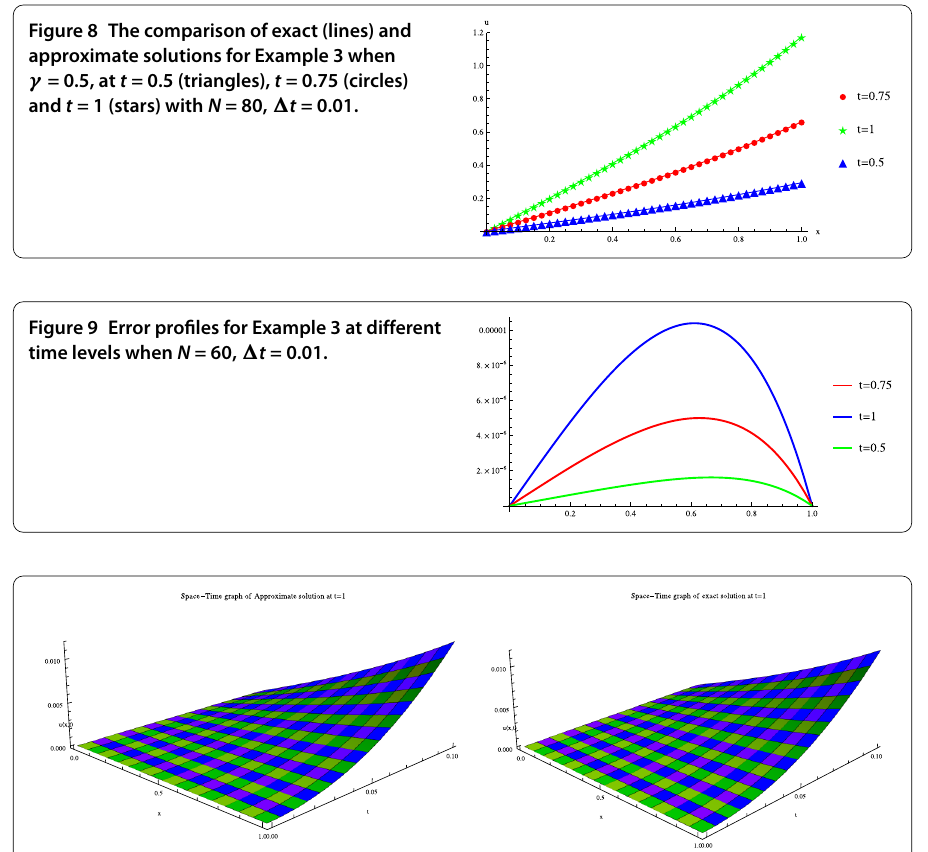
Figure 9 Error profiles for Example 3 at different time levels when N = 60, (cid:2) t = 0.01.